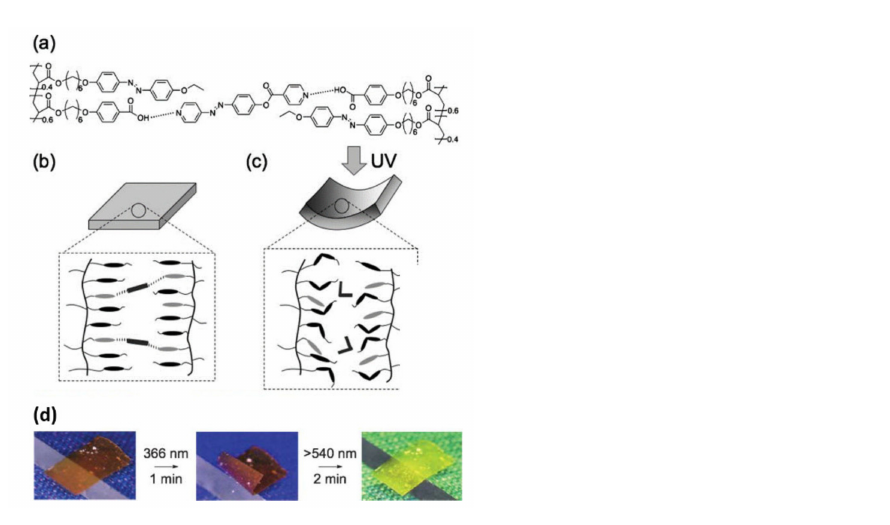
Figure 2. ( a – c ) Plausible mechanism of bending in the H-bonded crosslinked LCP film of an azo copolymer and an azo crosslinker: ( a ) network structure of the H-bonded crosslinked LCP film consisting of the azo copolymer and the azo crosslinker; ( b , c ) schematic illustration of molecular alignment in the H-bonded crosslinked LCP film before ( b ) and after ( c ) irradiation with UV light. ( d ) Photoresponsive behavior of the H-bonded crosslinked LCP film. Size of the film: 2 mm × 3 mm × 20 µ m. UV light intensity: 18 mW cm − 2 ; visible light intensity: 21 mW cm − 2 . Reprinted with permission from Reference [33]. Copyright 2008 Royal Society of